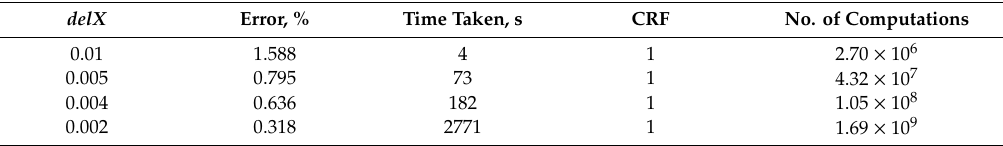
Table 1. Computation of view factor using UPG routine. Example with perpendicular, whole surfaces, uniform reflectance. Routine: Uniform Populous Grid, UPG *.